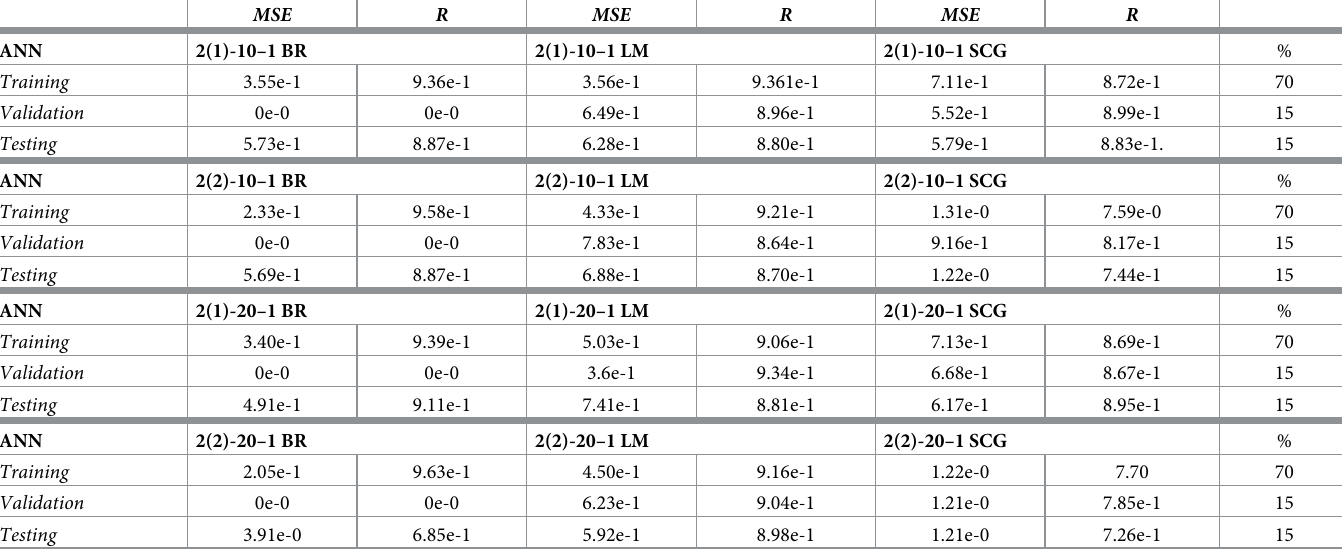
Table 4. BR—Bayesian Regularization training, LM -Levenberg-Marquardt training algorithm, SCG—Scaled Conjugate Gradient, the number in the brackets indi- cates the size of the time window delay for input and output, (2) two past values included, or (1) single past value included, evaluated for pine data set, see Fig 2. MSE